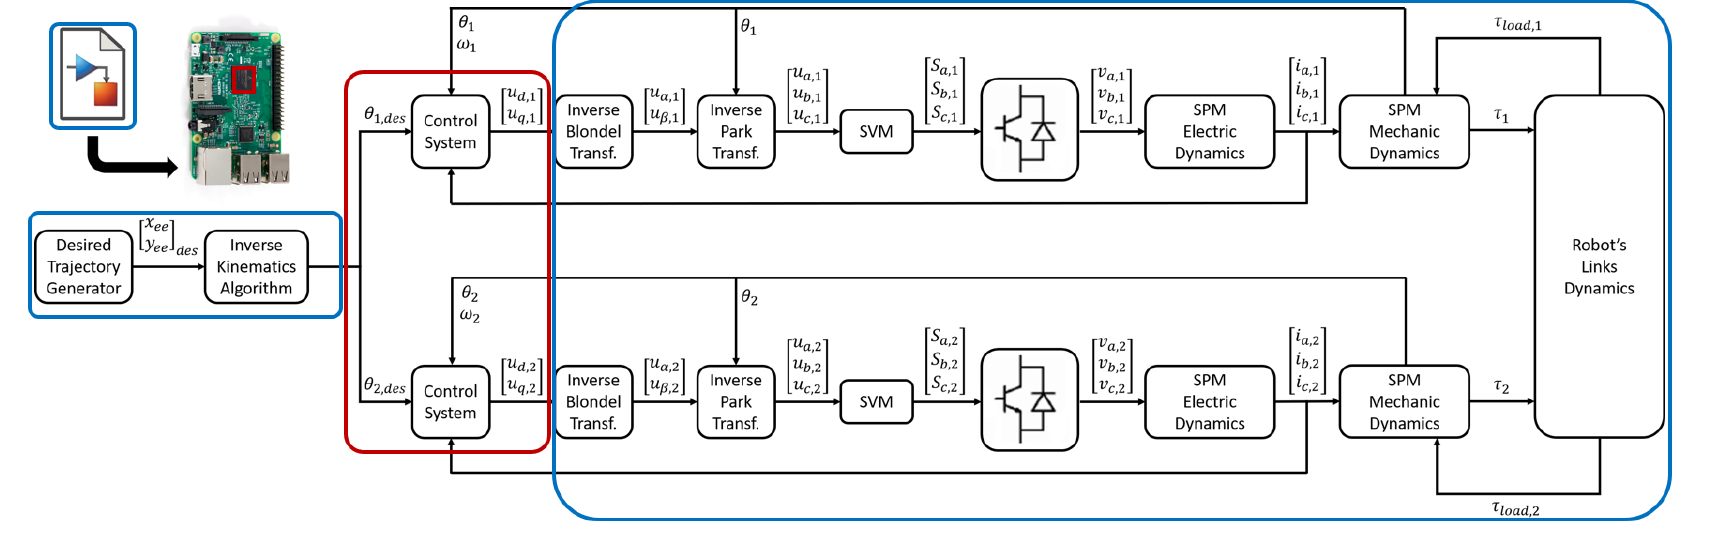
Figure 4. High level Description of the System